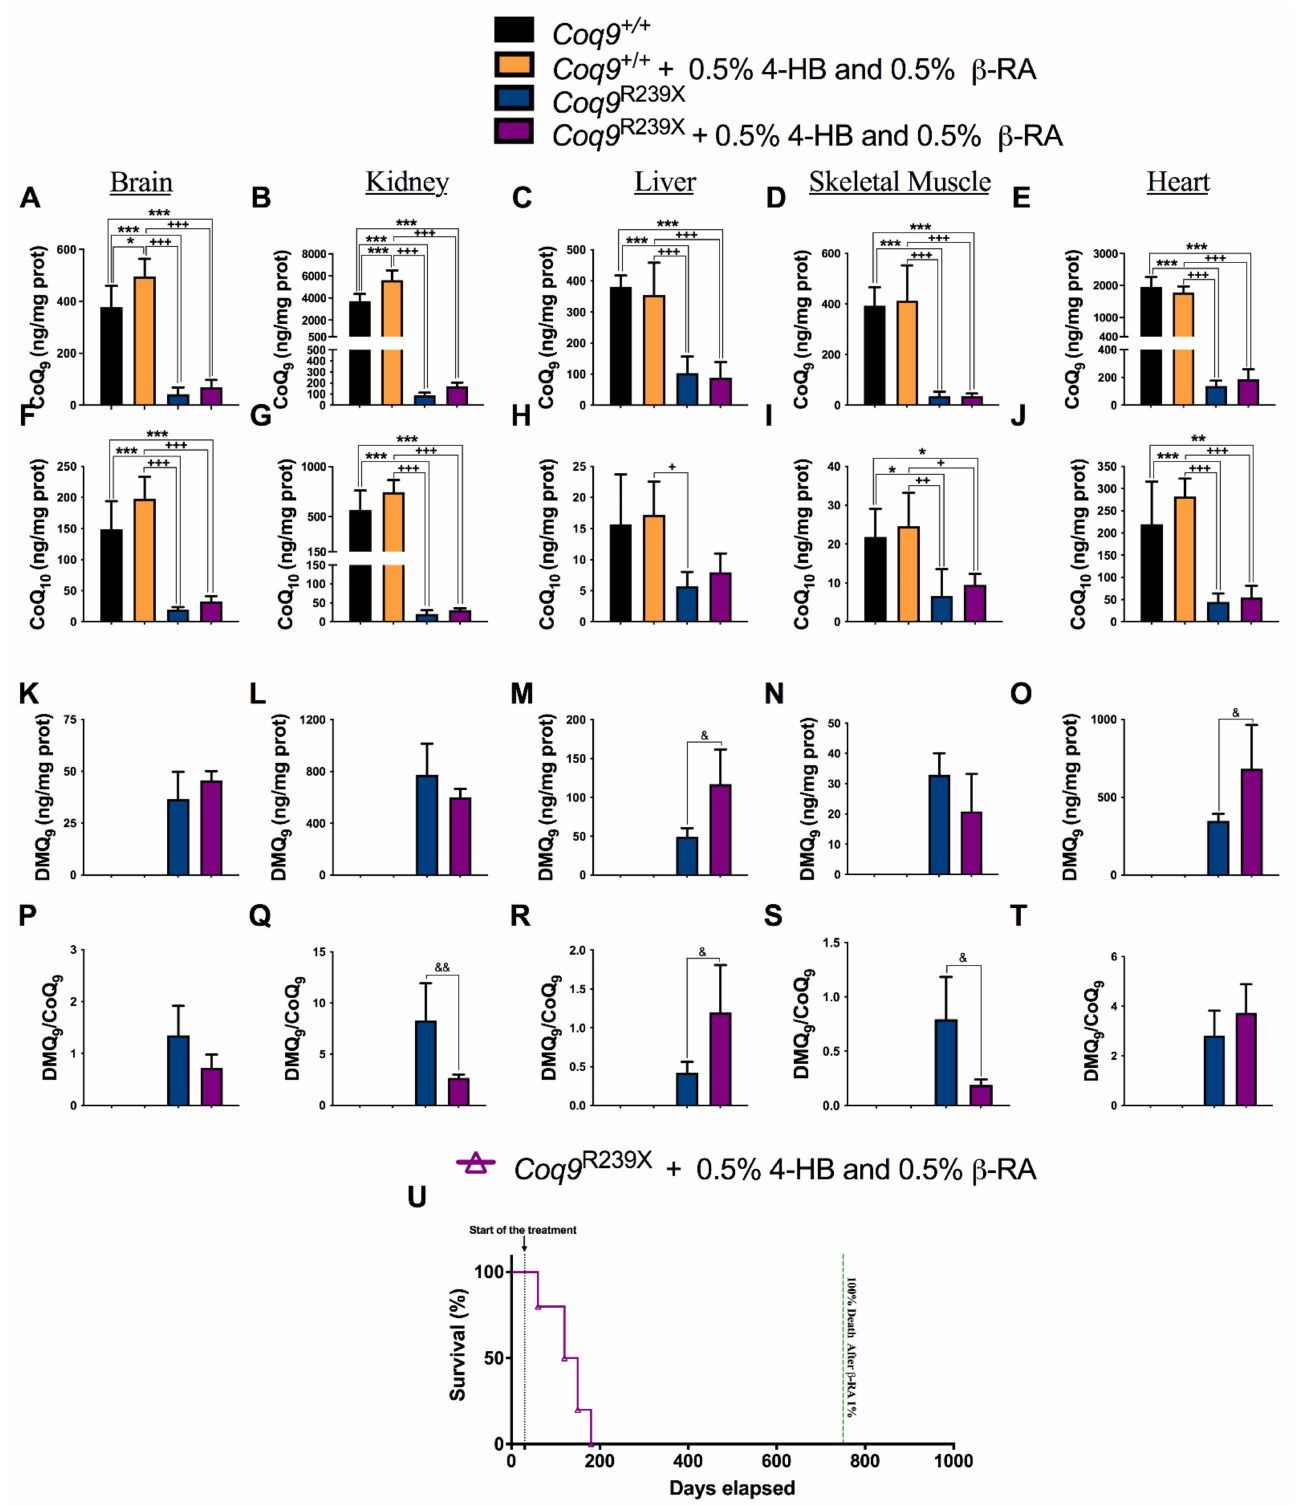
Figure 4. Co-administration of 4-HB suppressed the effects of the β -RA treatment in the Coq9 +/+ and Coq9 R239X mice. ( A – E ) Levels of CoQ 9 in the brain ( A ), kidneys ( B ), liver ( C ), skeletal muscle ( D ), and heart ( E ) from the Coq9 +/+ mice, Coq9 +/+ mice given the 0.5% 4-HB + 0.5% β -RA treatment, Coq9 R239X mice, and Coq9 R239X mice given the 0.5% 4-HB + 0.5% β -RA treatment. ( F – J ) Levels of CoQ 10 in the brain ( F ), kidneys ( G ), liver ( H ), skeletal muscle ( I ), and heart ( J ) from the Coq9 +/+ mice, Coq9 +/+ mice given the 0.5% 4-HB + 0.5% β -RA treatment, Coq9 R239X mice, and Coq9 R239X mice given the 0.5% 4-HB + 0.5% β -RA treatment. ( K – O ) Levels of DMQ 9 in the brain ( K ), kidneys ( L ), liver ( M ), skeletal muscle ( N ), and heart ( O )